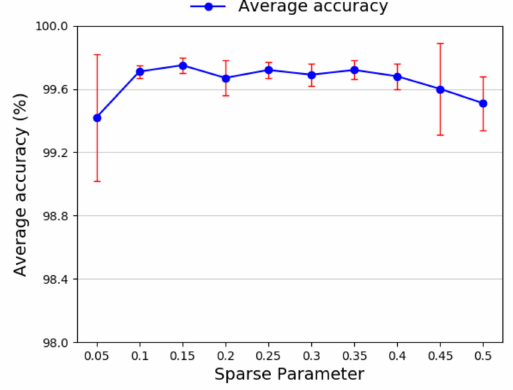
Figure 15. Diagnosis accuracy of di ff erent sparse